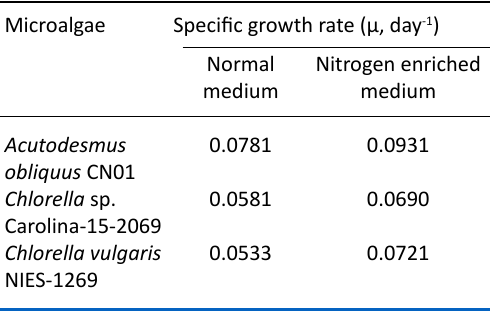
Table 1. Specific growth rate of microalgae in normal medium and nitrogen enriched medium